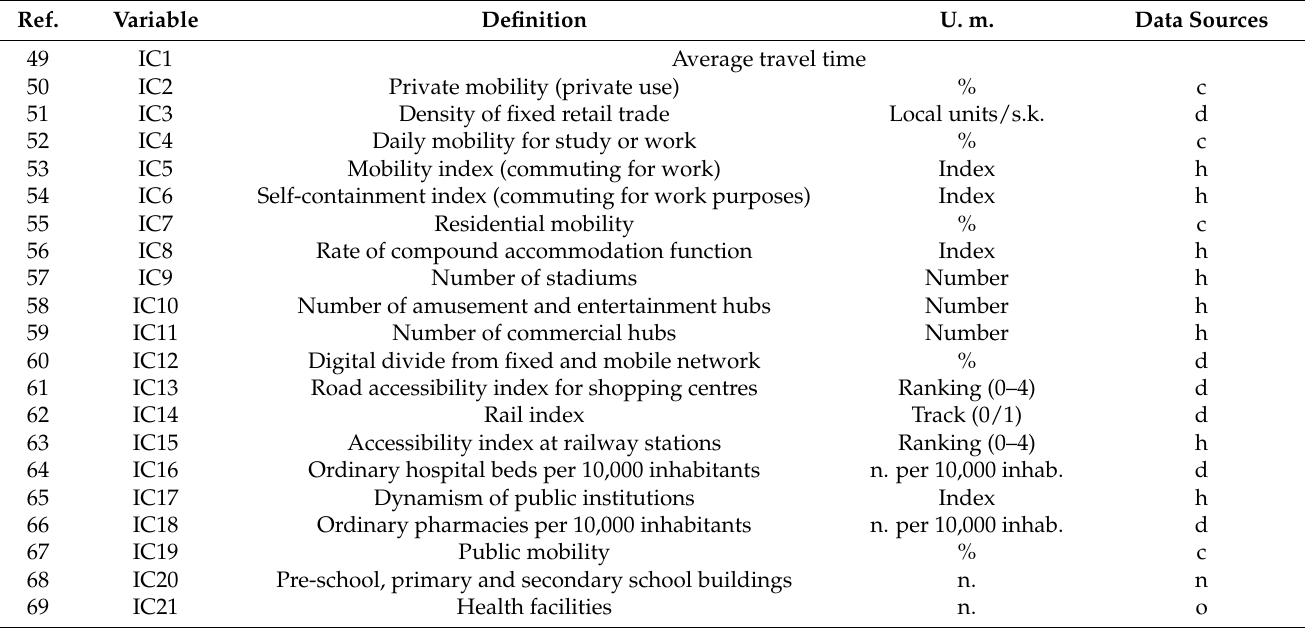
Table 4. Infrastructural capital indicators.